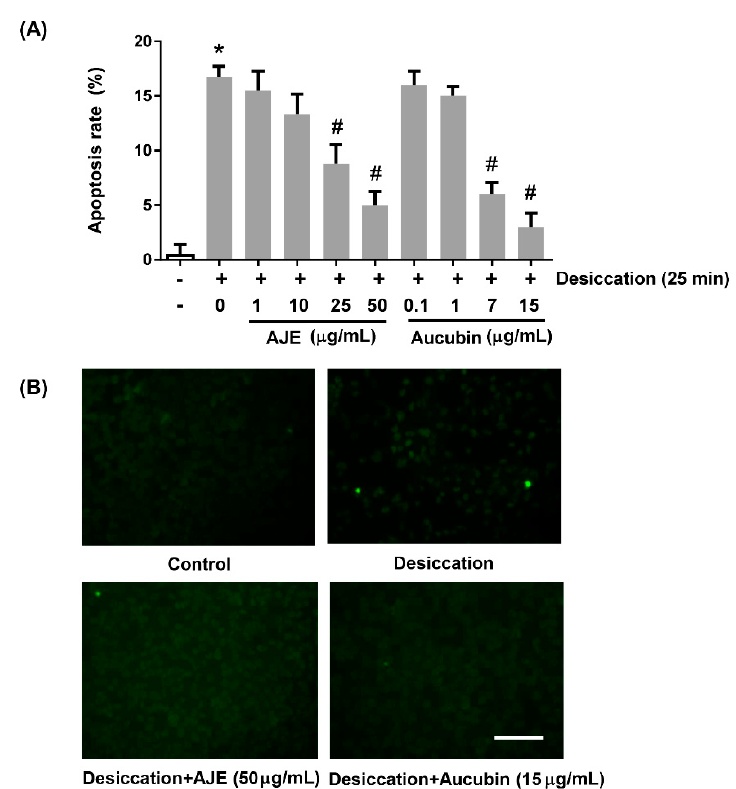
Figure 3. Effects of AJE and aucubin on apoptosis rate of human corneal epithelial cell under desiccation. The cell was pre-incubated with various concentrations of AJE and aucubin for 24 h and then exposed to air to induce desiccation stress. After that, the cells were fixed and performed TUNEL staining. ( A ) Apoptosis rate was calculated by comparing the ratio of TUNEL-positive cells to total cell number. ( B ) The images were taken under the fluorescence microscope after TUNEL staining. Scale bars = 100 µ m. The values in bar graph represent the mean ± SE. * p < 0.05 vs. control cell, # p < 0.05 vs. vehicle treated cell.